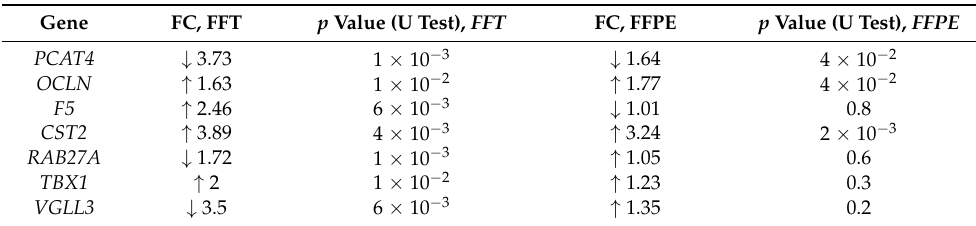
Table 3. The results of the relative expression of CST2 , F5 , OCLN , PCAT4 , RAB27A , TBX1 , and VGLL3 genes between groups N0 and N1 based on the U test.